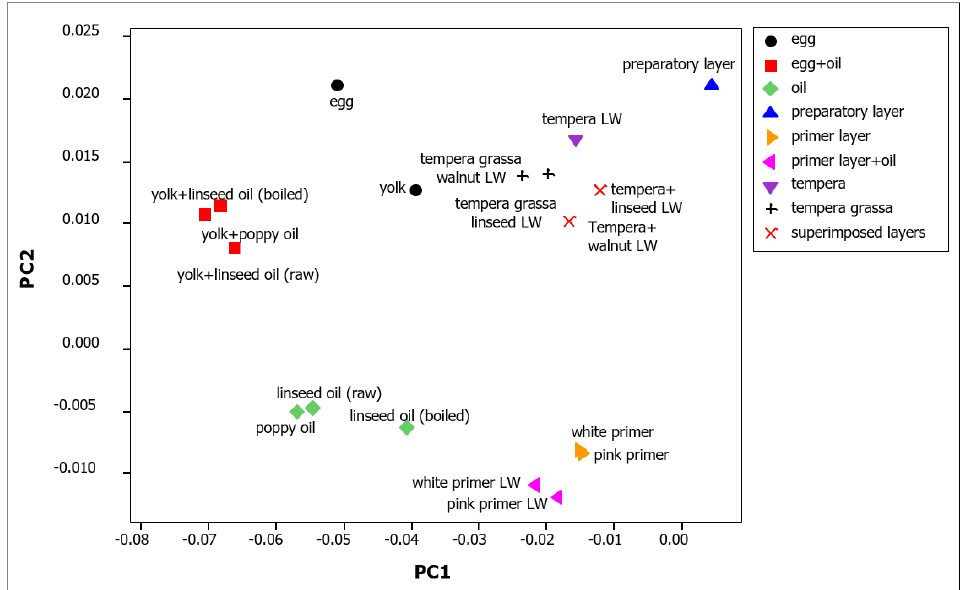
Figure 4. Score plot of the first two principal components of the NIR spectra (6000–4000 cm − 1 ) of pure binders and of model painting samples on calcite ground layer. In the model samples, lead white (LW) was used as pigment.